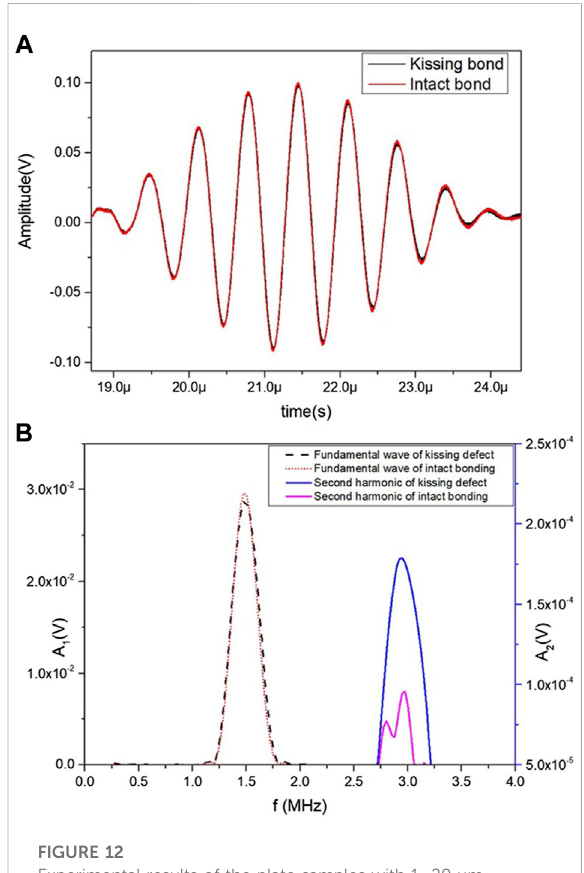
FIGURE 12 Experimental results of the plate samples with 1 – 20 μ m defect (A) Time domain signal, (B) Spectrogram (Wang et